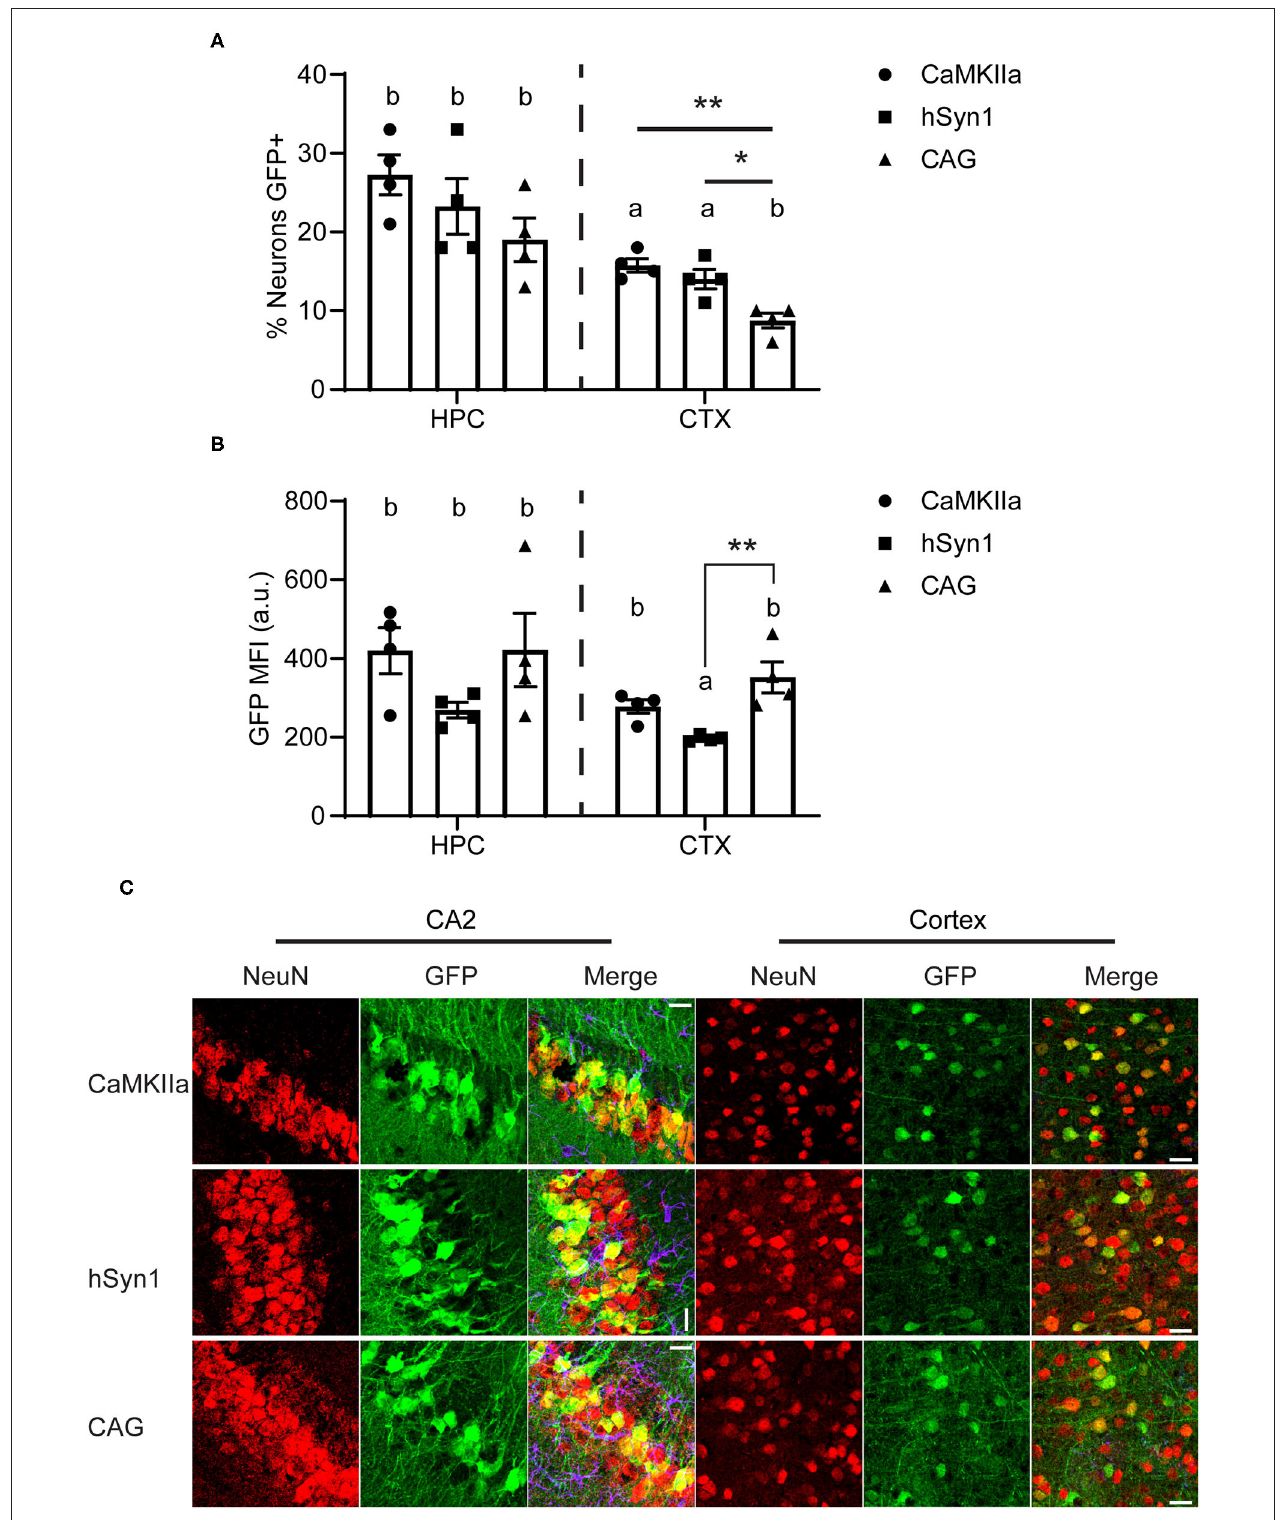
FIGURE 4 | The neuron-specific promoters transduce a greater percentage of NeuN + cells than the CAG promoter. (A) Graph of approximate percentage of NeuN-positive cells also expressing GFP. Both neuron-specific promoters transduced significantly more cells in the cortex than the ubiquitous CAG promoter.